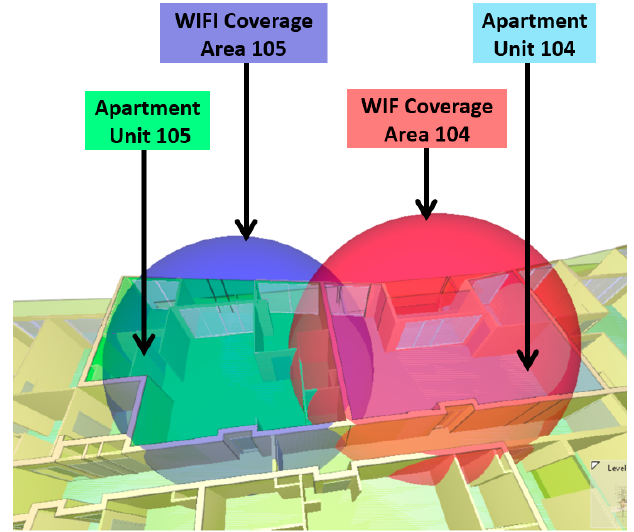
Figure 9. Two adjacent apartment units and their counterpart WiFi coverage spaces.